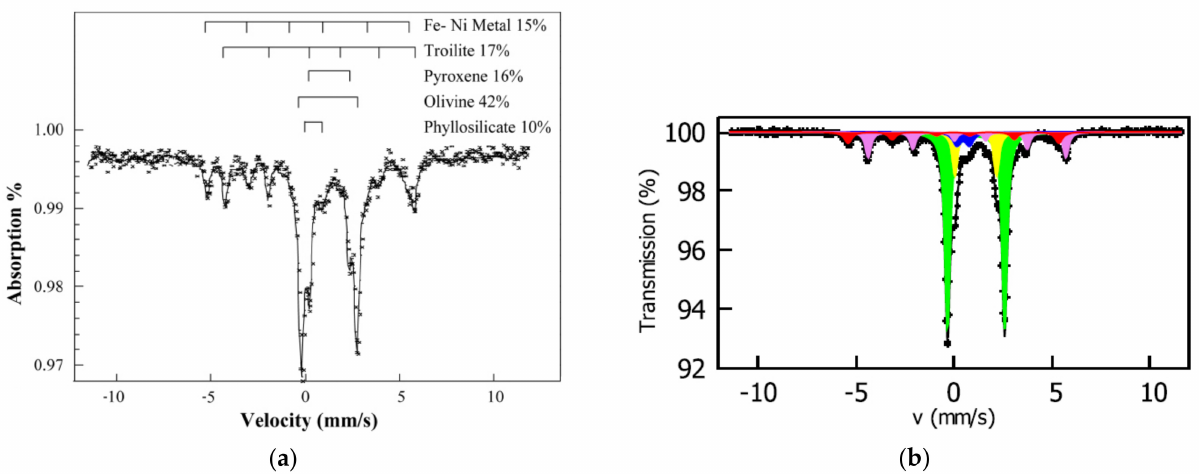
Figure 30. Room temperature Mössbauer spectra of unequilibrated ordinary chondrites Bishunpur LL3.15 [53] ( a ) and Chainpur LL3.4 [102] ( b ). Indicated components are the results of the fits. Adapted from References